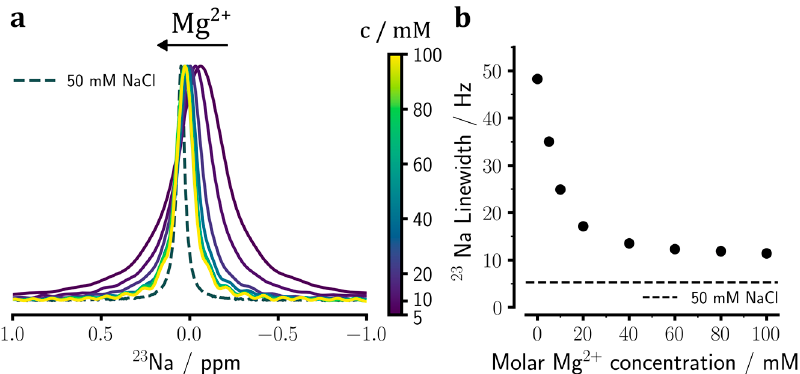
Figure 3. 23 Na NMR spectral changes of sodium heparin caused by the addition of Mg 2+ ions and the consequent release of sodium ions from heparin. ( a ) Upon titration of sodium heparin with 0 to 100 mM MgCl 2 , the 23 Na chemical shift gets narrower and moves downfield towards the chemical shift of the reference NaCl sample (see Figure 1). ( b ) Changes in the 23 Na signal linewidth in dependence of added Mg 2+ ion concentration, showing a monotonic decrease approaching a value slightly larger than the linewidth of the reference NaCl sample (represented by the dashed line). The spectra shown in ( a ) are re-scaled according to their peak intensities. The error bars in ( b ) are comparable in size to the symbols and, therefore, barely visible.